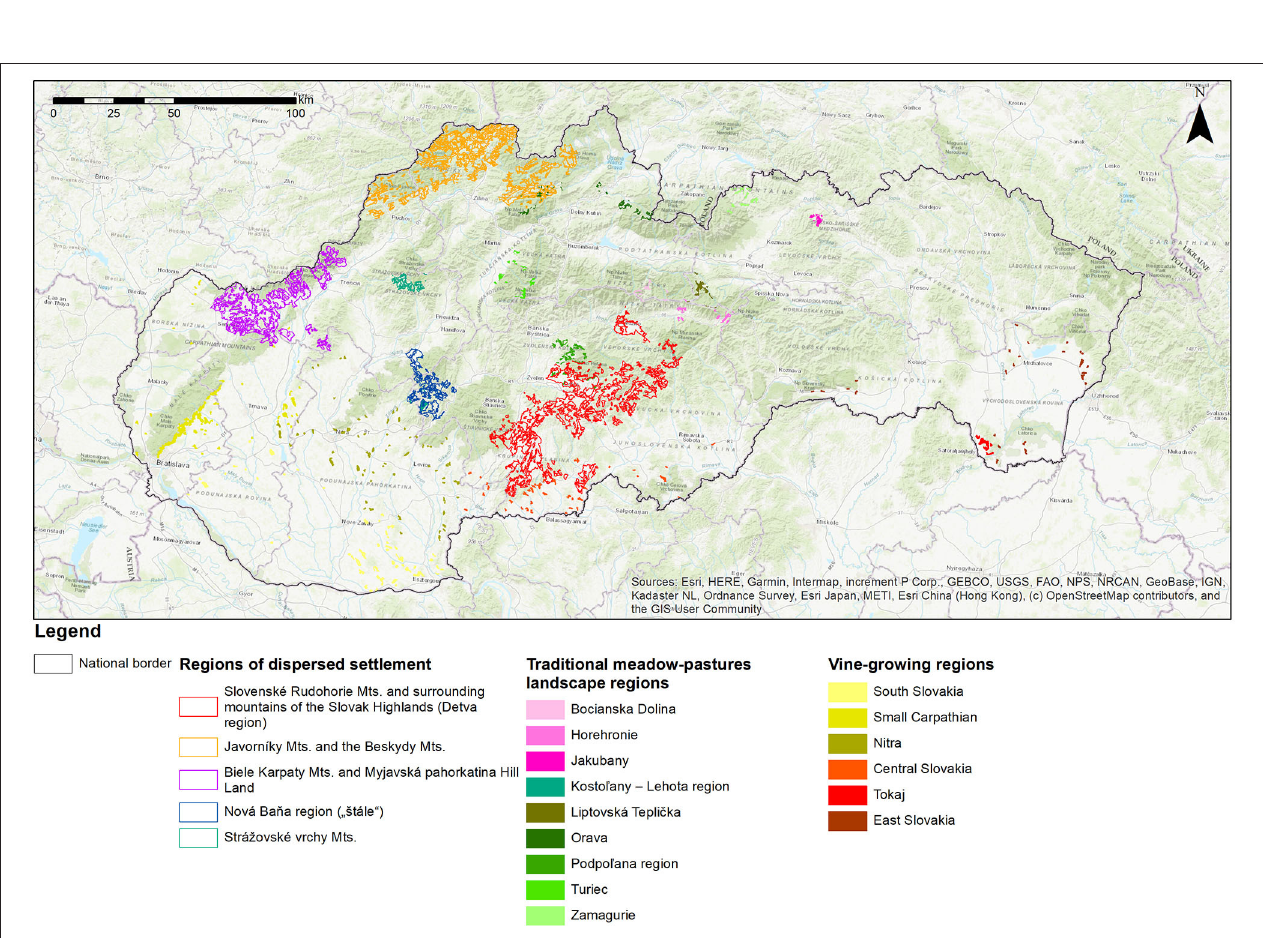
FIGURE 10 | The most significant regions of traditional agricultural landscapes.